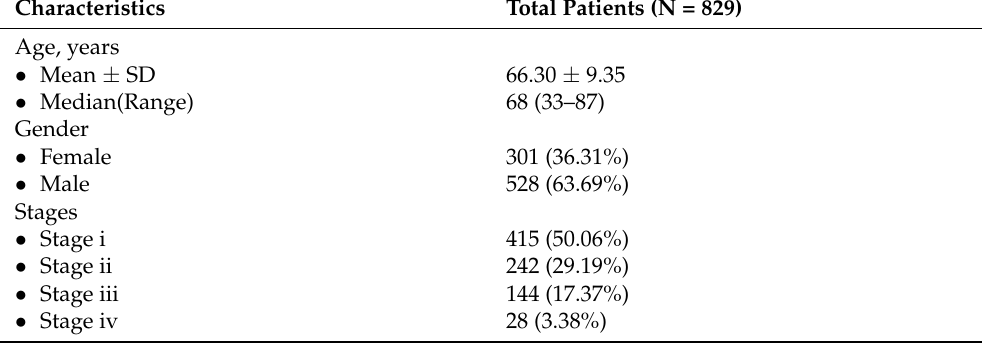
Table 1. Clinical baseline information of 829 primary NSCLC patients.